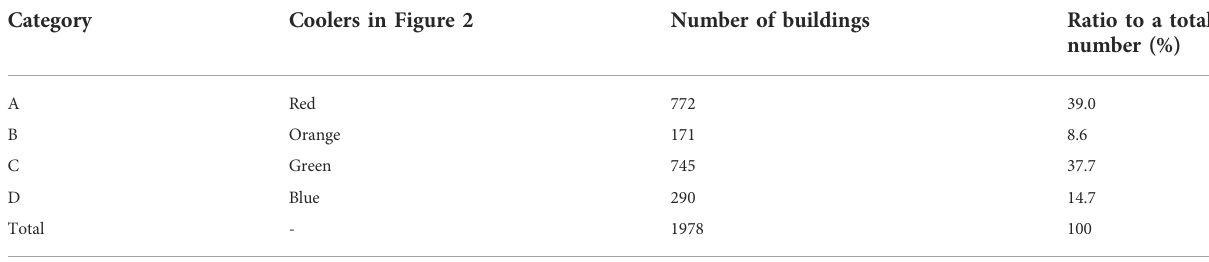
TABLE 2 Evaluated building numbers for each category in the survey area.